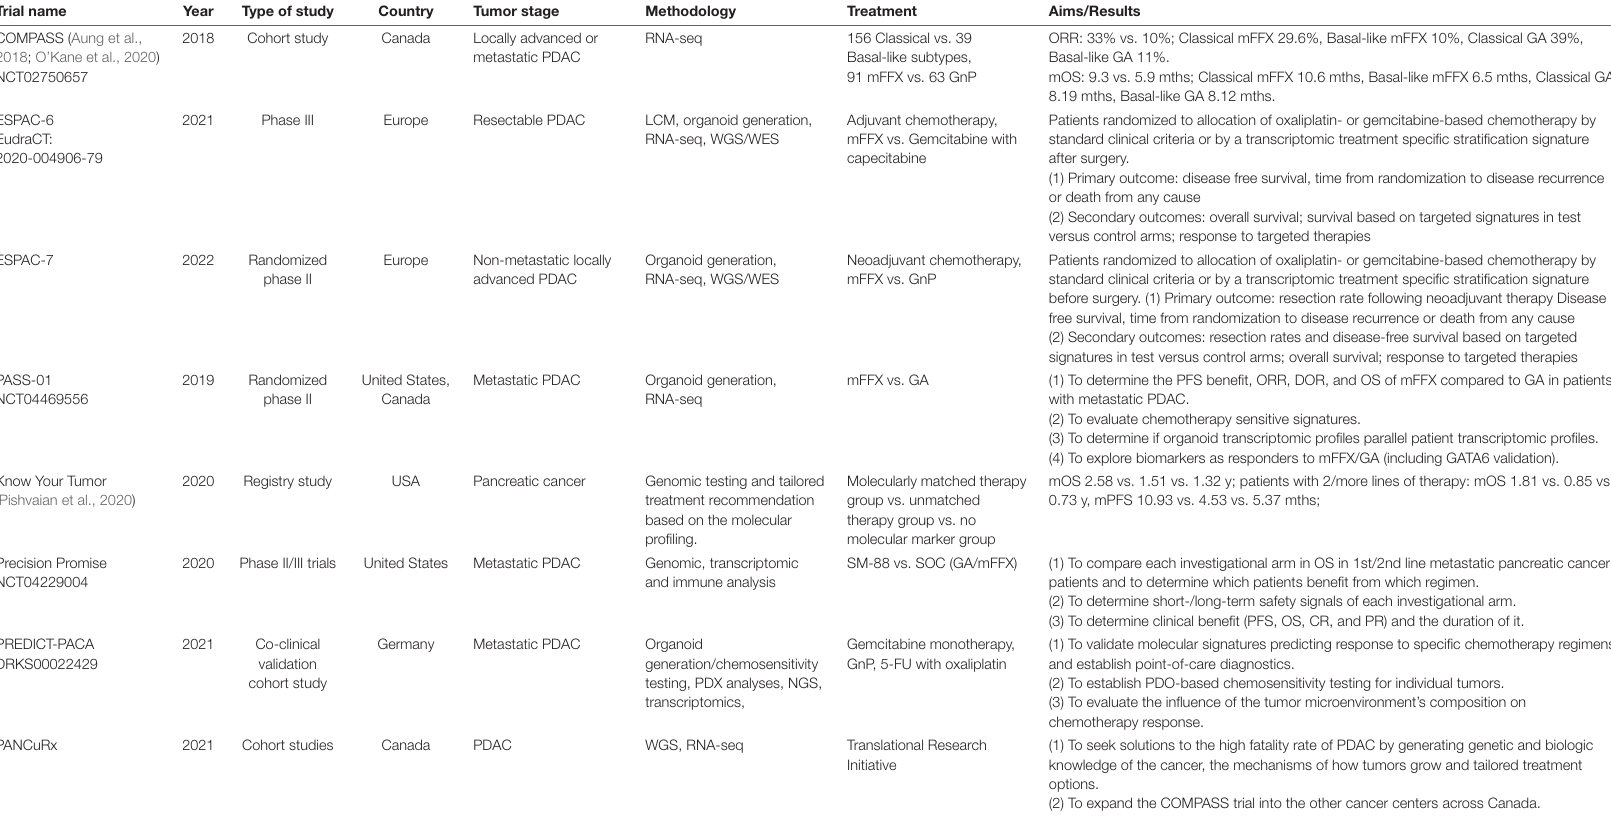
TABLE 3 | Translational clinical trials with molecular subtyping. Trial name